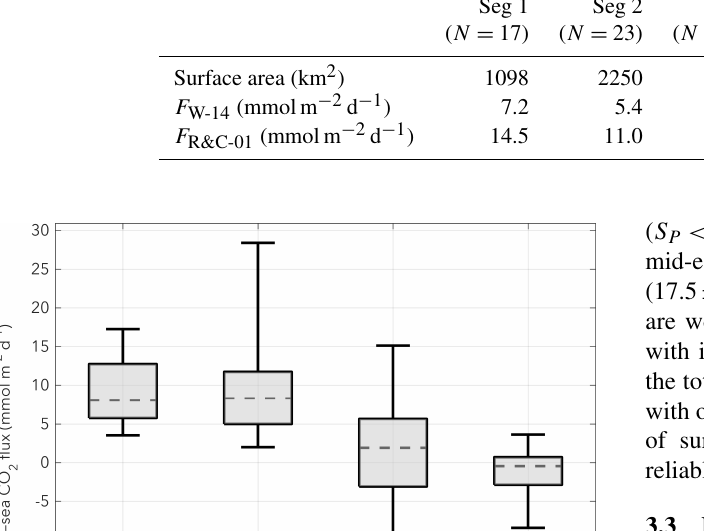
Table 3. Sectional and area-averaged air–sea CO 2 fluxes (mmolCm − 2 d − 1 ) in the SLE during all sampling months. To obtain the area- averaged CO 2 flux, the SLE was divided into five segments at equal intervals. The first row of the table shows the surface area (km 2 ) of each segment. The flux data in each segment were numerically averaged to obtain sectional fluxes, which were then area weighted and summed to obtain the spatially integrated whole-estuary flux (in bold). The F W-14 and F R&C-01 data provide the lower and upper estimates, respectively. Seg 1